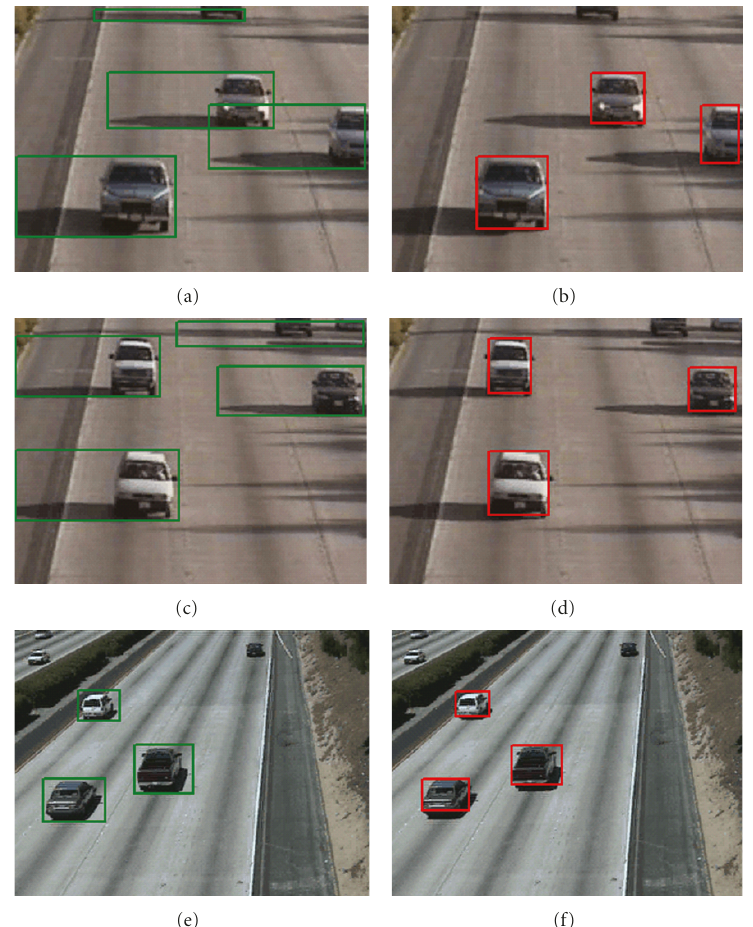
Figure 29: Experimental results of foreground object